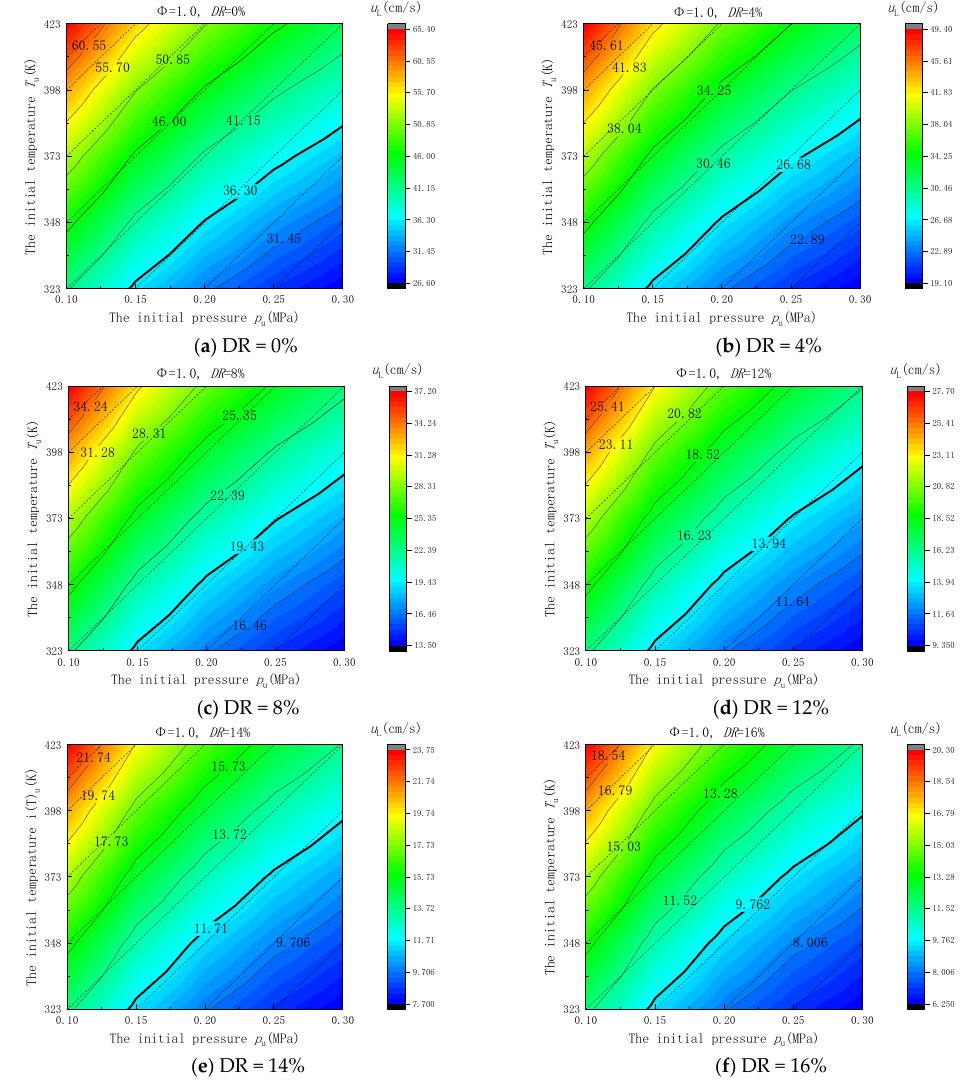
Figure 8. The equivalent distribution pattern of u L under the coupling effect of Tu and Pu when Φ is 1.0 and when the dilution rates are 0%, 4%, 8%, 12%, 14% and 16%.